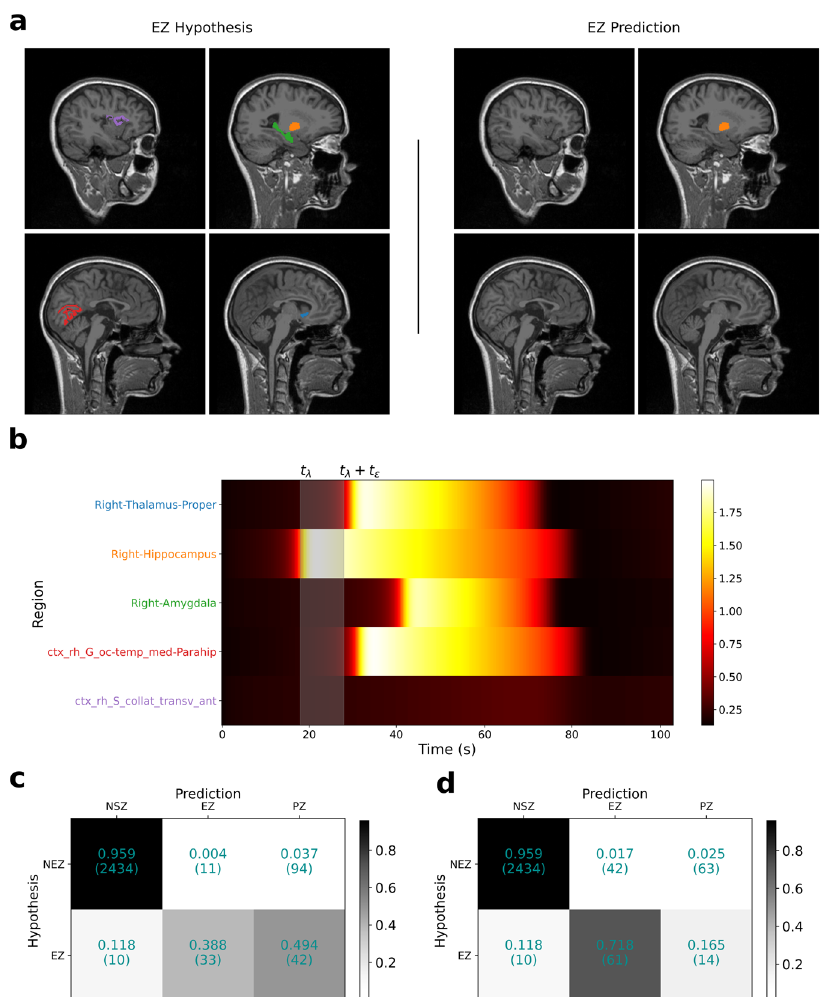
Fig. 5 Inferred seizure propagation pattern in patient LMA with Engel score I. a Comparison of clinical EZ hypothesis (left) with model-predicted EZ (right). b Model-predicted seizure propagation pattern as observed in the predicted source power. c Confusion matrix comparing clinical classi fi cation of brain regions and model prediction-based classi fi cation across all patients in the Engel score I/II group at onset tolerance ( t ϵ ) of 10 s. d Same as in ( c ), except t ϵ = 30 s. Fitting between model predictions and observed data features is shown in Supplementary Fig. 3. EZ, epileptogenic